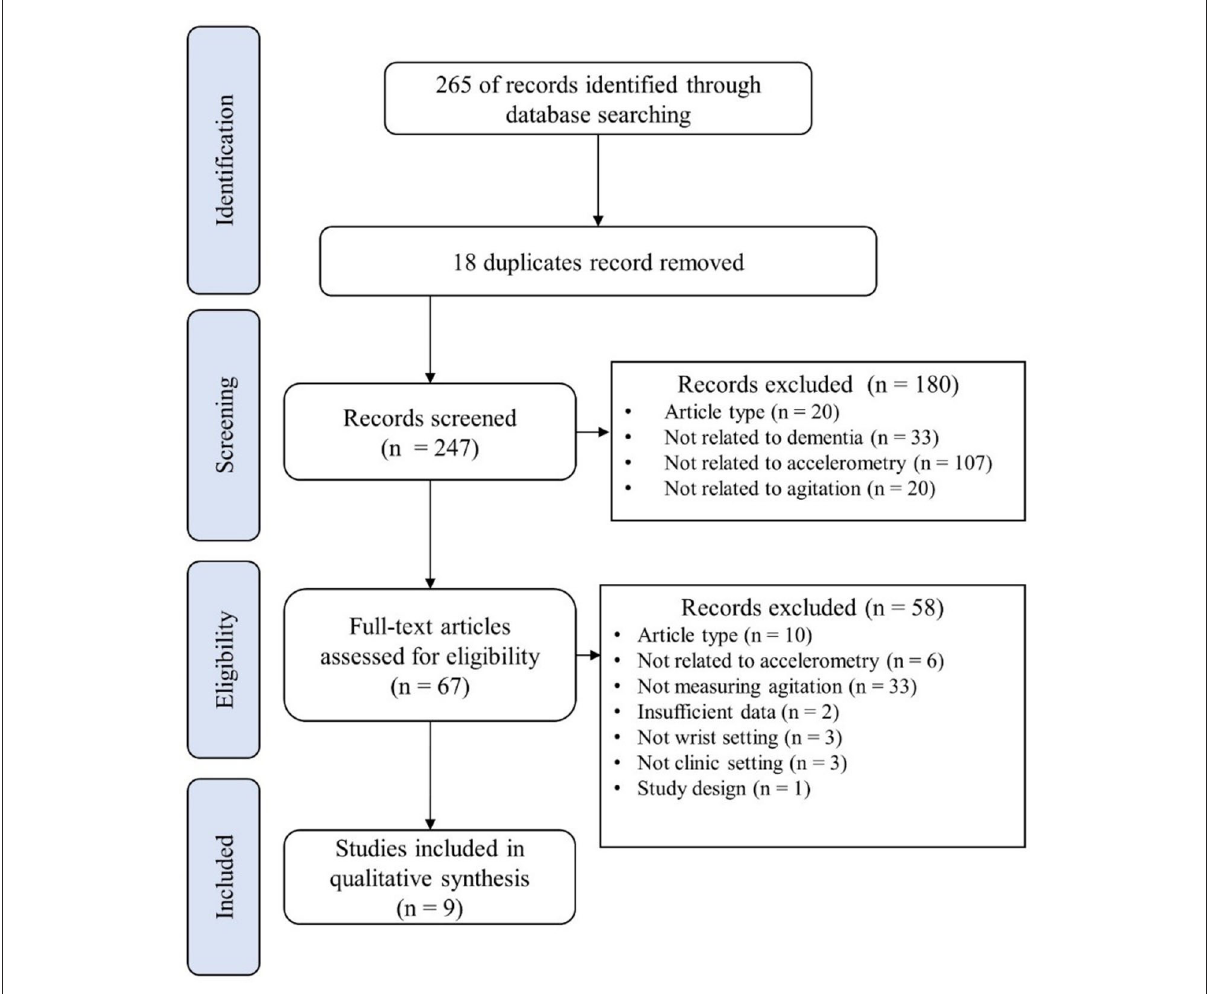
FIGURE1 Flowchart of the systematic search and